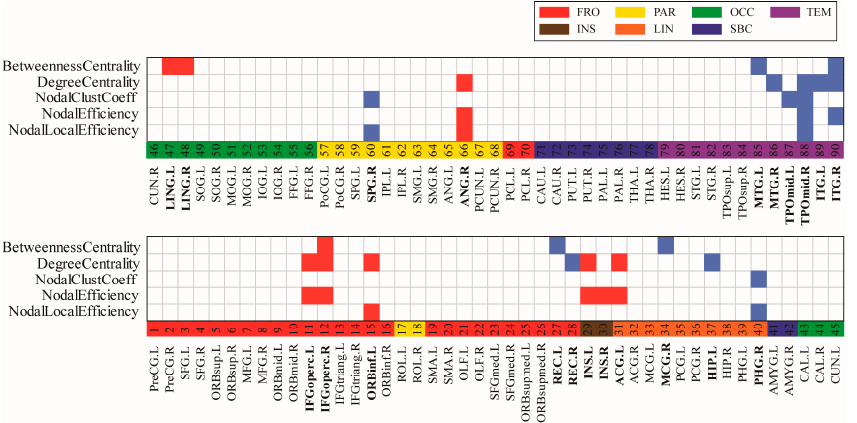
Figure 3. The regions with significant differences in nodal properties between groups; p < 0.05. The significant increase and decrease in node network indicators are marked in red and blue, respectively, indicating that the two groups of nodes in AAL90 were analyzed using a two-tailed independent sample t -test in nodal local efficiency, nodal efficiency, nodal clustering coefficient, degree centrality and betweenness centrality. The brain lobes were marked with different colors: red for the frontal lobe, yellow for the parietal lobe, green for the occipital lobe, purple for the temporal lobe, brown for the insula, orange for the limbic system and blue for the subcortex.